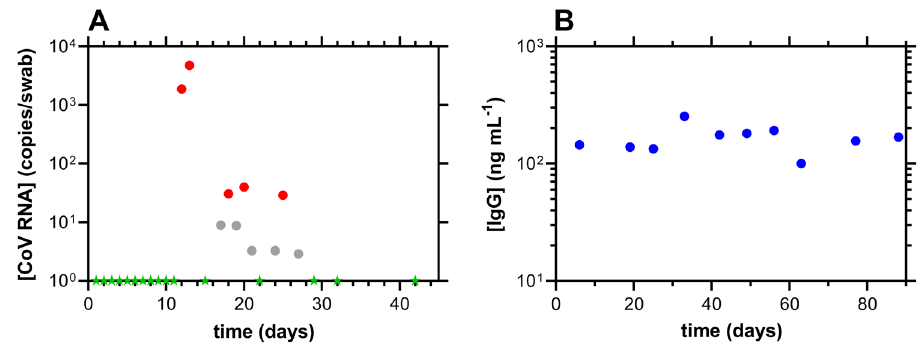
Fig. 7 Longitudinal nasal swab SARS-CoV-2 viral load kinetics and corresponding humoral responses for subject 82. Day 1 corresponds to the fi rst RT- qPCR sample. A nasal swab SARS-CoV-2 RT-qPCR measurements; red, positive; gray, inconclusive; green, negative. B Serum IgG measurements; IgA and IgM concentrations were BLQ in all serum (144 ng mL − 1 ) corresponds to the period of SARS-CoV-2 nega- tivity by RT-qPCR.